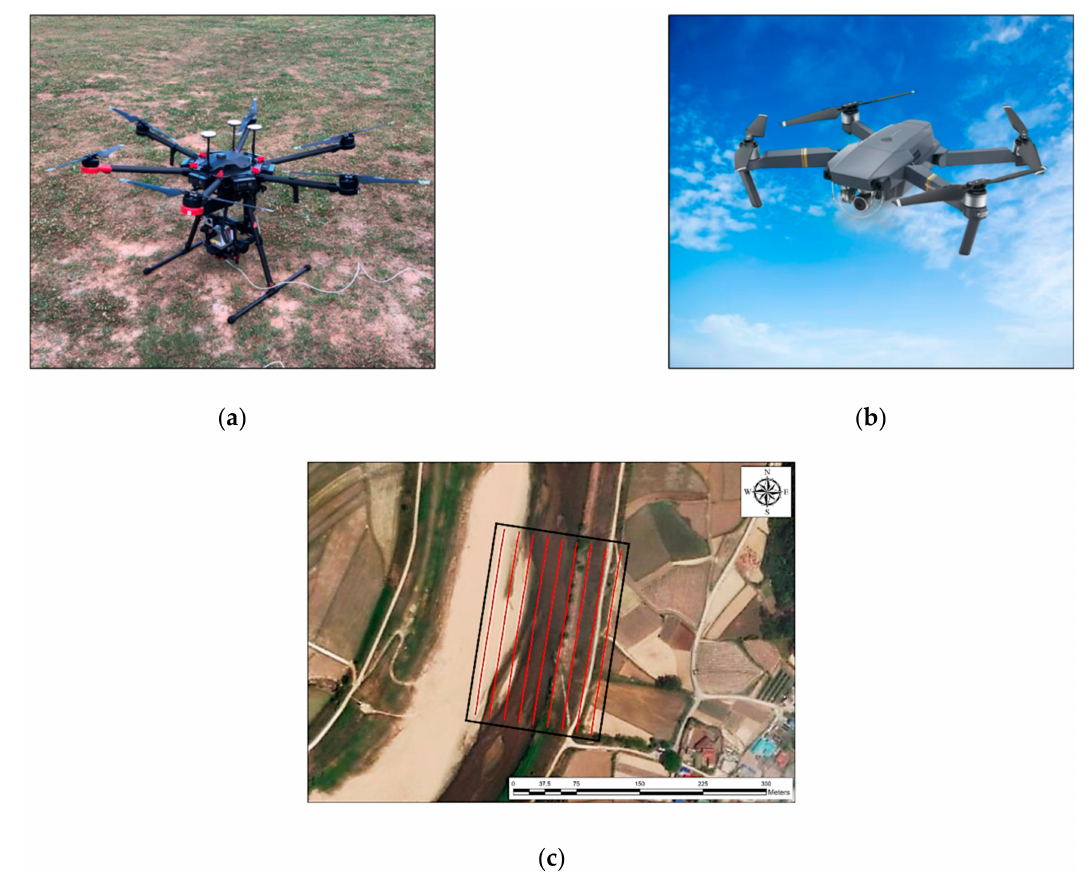
Figure 8. Data collection overview: ( a ) DJI Mavic Pro UAV, as used for optical image collection; ( b ) DJI Matrice 600 Pro UAV, as used for hyperspectral image collection; ( c ) red lines indicate the nine flight